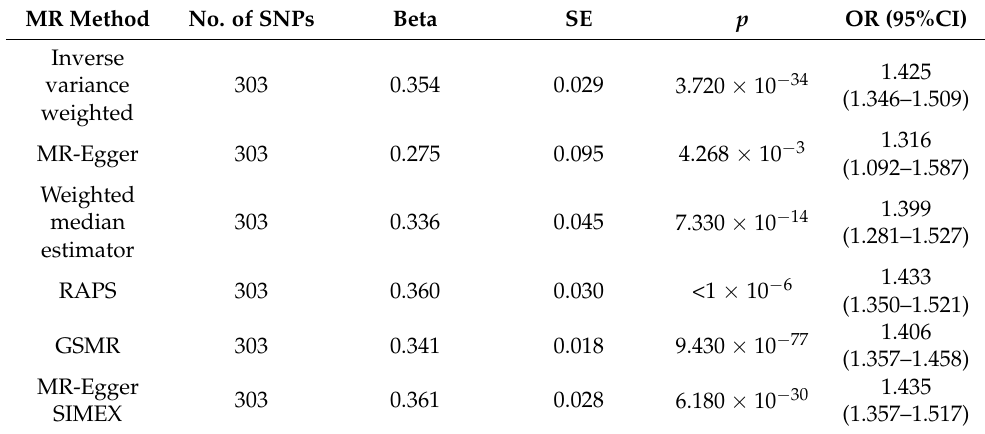
Table 1. MR estimates from each method of assessing the causal effect of BMI on the risk of AF.